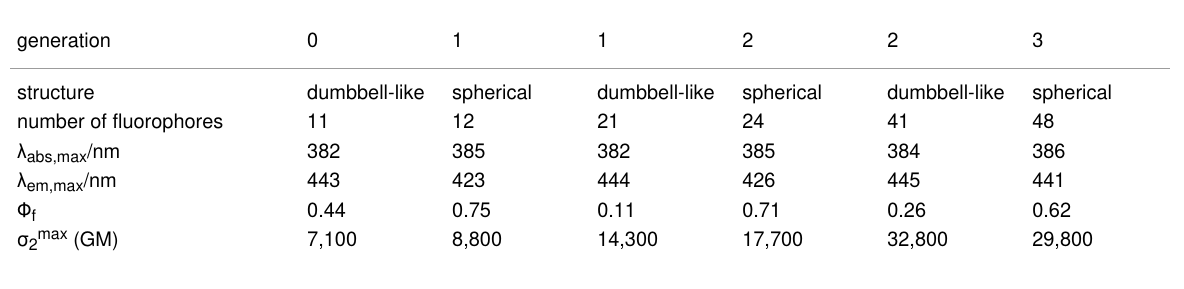
Table 2: Comparison of the photophysical properties (in toluene) of the spherical dendrimers shown in Scheme 2, with that of the dumbbell-like dendrimers shown in Figure 7.